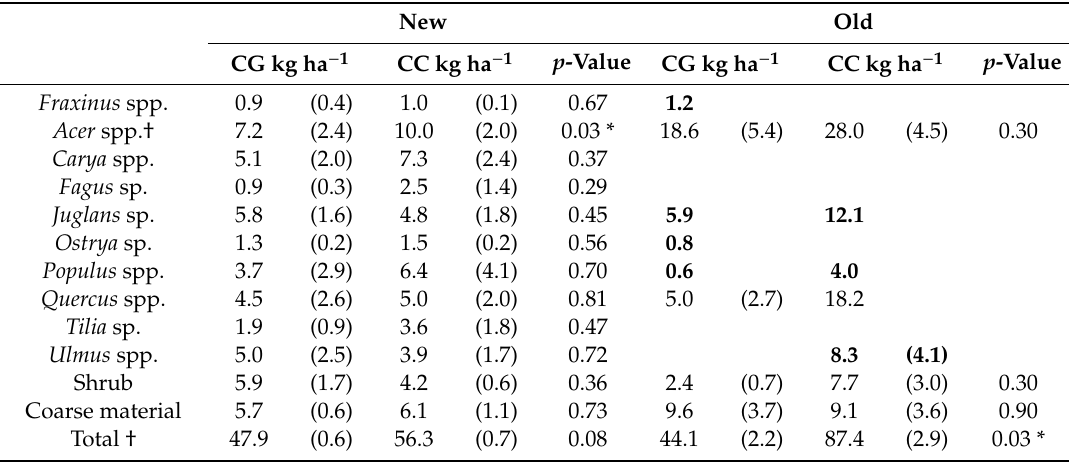
Coarse material